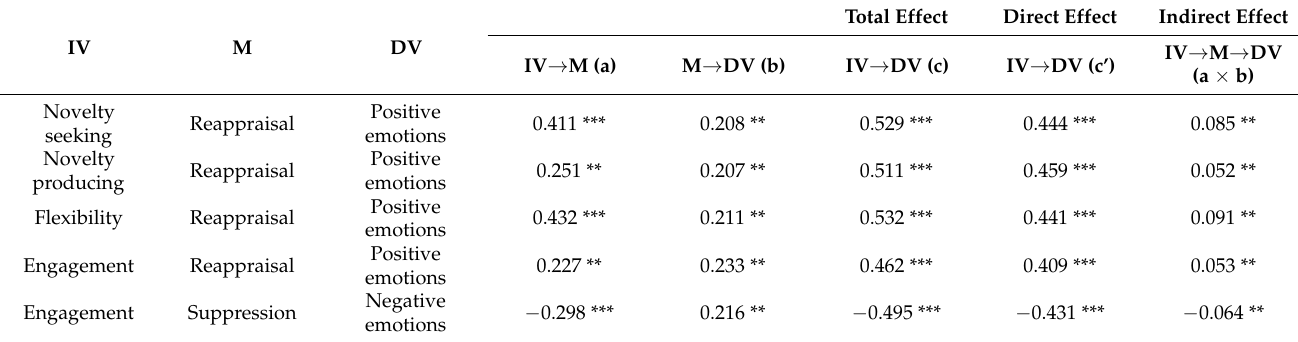
Table 2. Indirect Effects of Socio-cognitive Mindfulness on Achievement Emotions through Emotion Regulation: Path Analysis ( N =